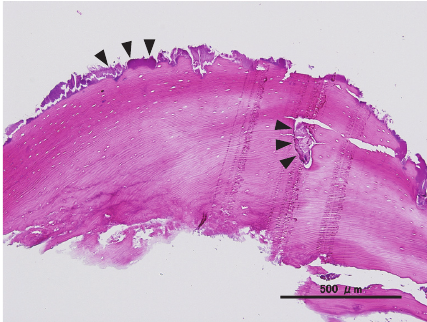
Figure 9: Histopathological findings (hematoxylin and eosin stain, slight magnification). Bone tissue, consisting of compact laminated structures, is void of cellular components but contains bacterial masses (arrow).